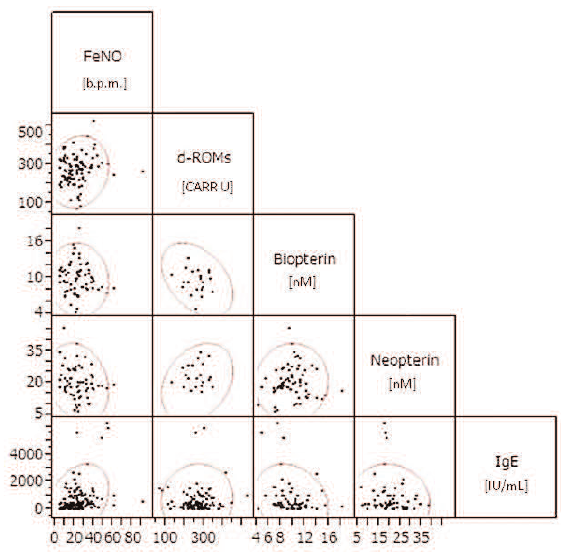
Figure 3.: Multivariate analysis of FeNO, d-ROMs, pteridines, and